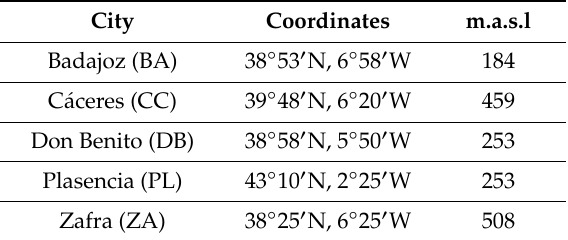
Table 1. Location of the cities